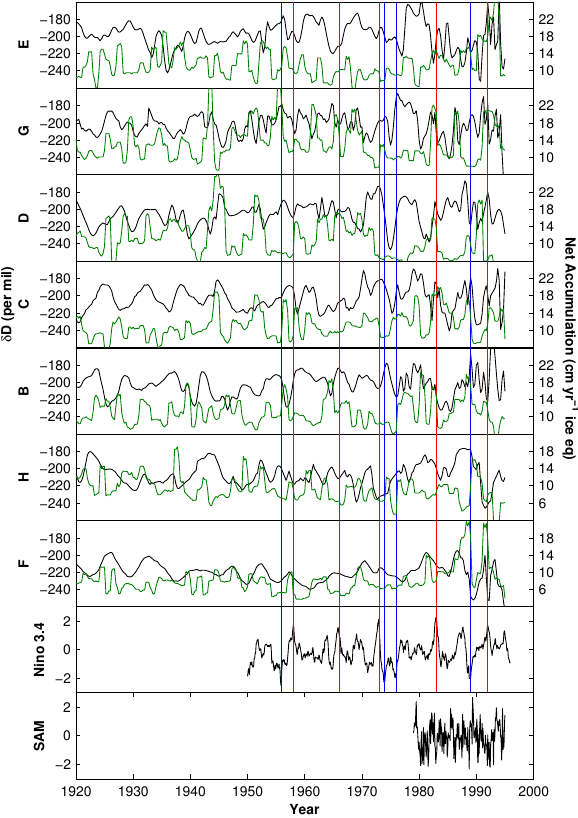
Figure 2. Siple Dome shallow ice core δ D (black lines) and net ac- cumulation records (green lines). The Niño 3.4 and SAM indexes are also shown. Strong El Niño years (red lines) and strong La Niña years (blue lines) are defined as 5 consecutive months greater than or less than 1.5 ◦ C sea surface temperature anomalies for the Niño 3.4 region, respectively. Figure 1. Top) Map of Antarctica centered on the Ross Sea region. www.jn.net The red dot is Siple Dome (SD), the blue dot is WAIS Divide (WD), and the green dot is Roosevelt Island (RI). WD and RI are recently drilled ice cores in close proximity to Siple Dome. Bottom) Local map of Siple Dome including grid locations of shallow ice cores B-H. The Pacific Flank cores are to the North of the Dome Summit, and the Inland Flank cores are to the South of the Dome Summit.